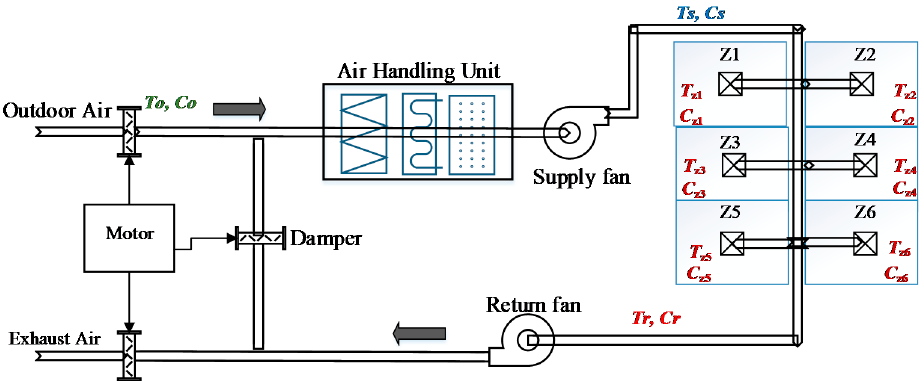
Figure 1. The framework of the air conditioning system for multi ‐ zone buildings.